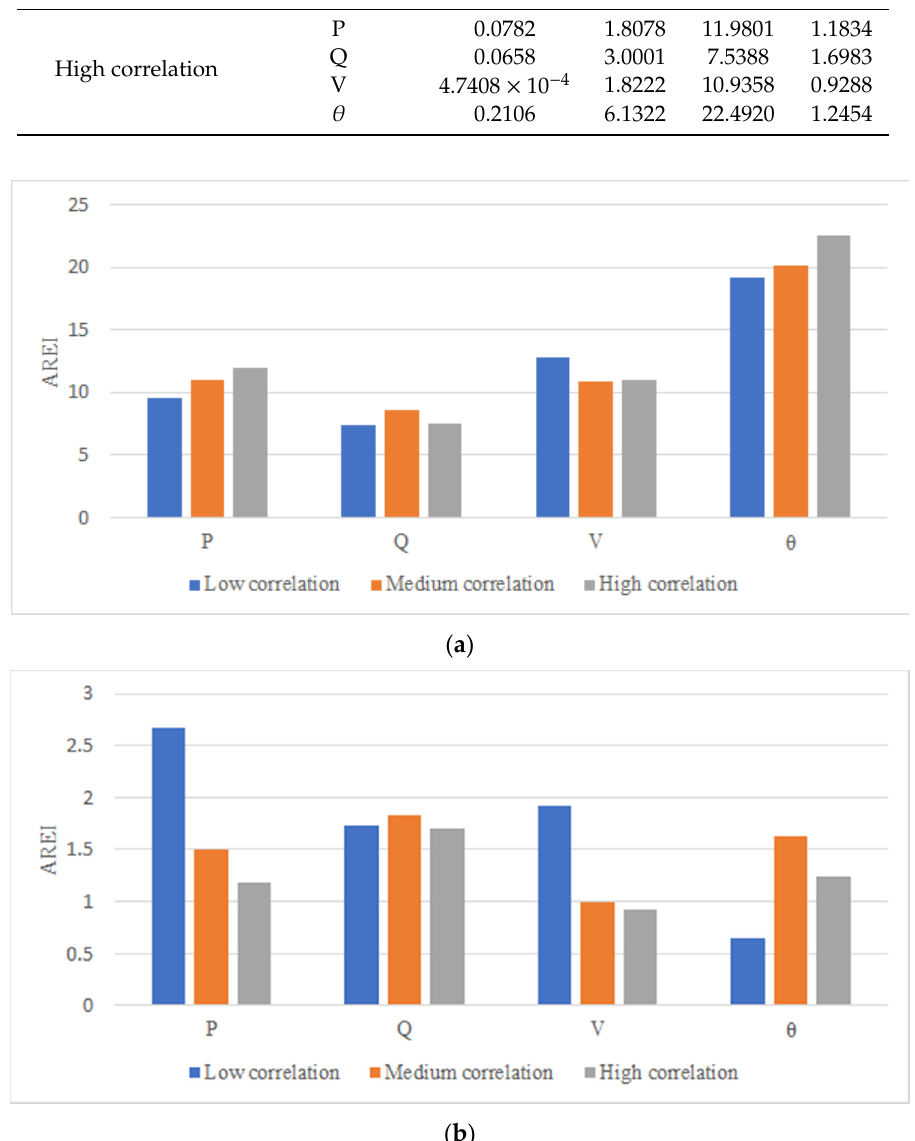
Figure 2. ( a ) 3 ε of three correlation scenarios and (b) 4 ε of three correlation scenarios. Figure 2. ( a ) ε 3 of three correlation scenarios and ( b ) ε 4 of three correlation